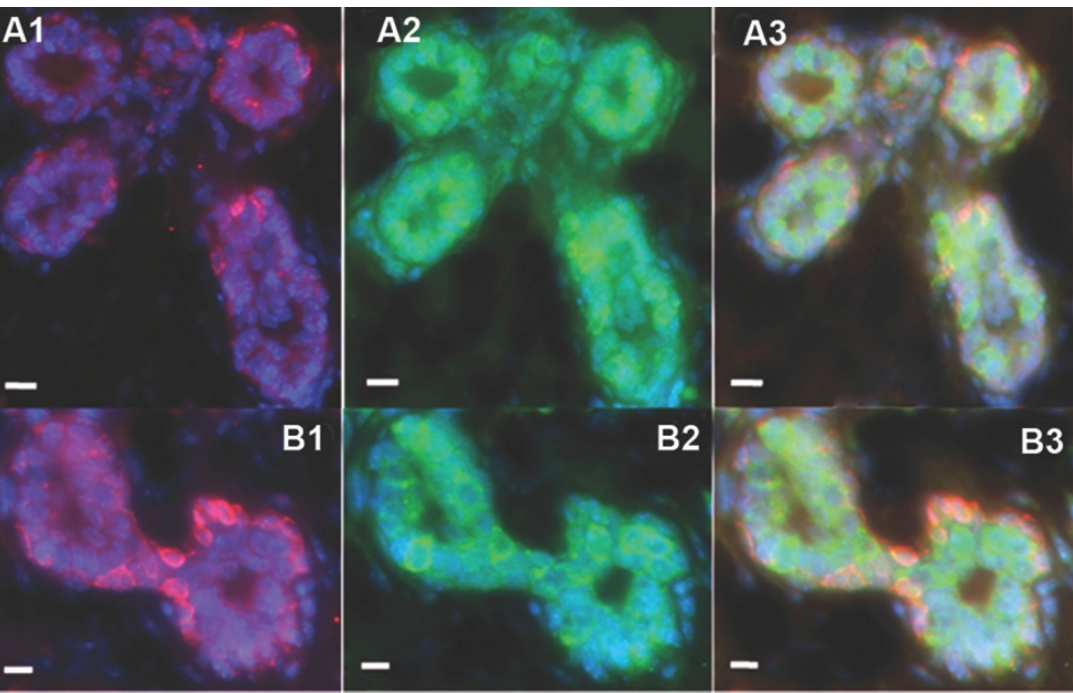
Figure 2. Human cancer cells are able to self-renew and contribute to both luminal (hK8-positive) and basal (hK5-positive) epithelial cell progeny in the chimeric mammary gland outgrowths. Immunofluorescence staining of primary (A1-A3) and secondary (B1-B3) mouse mammary outgrowths. Primary outgrowths were obtained by inoculating both human embryonal carcinoma (NT2) and normal mammary epithelial cells. Secondary outgrowths were generated by transplanting NT2/MEC primary mammary outgrowths fragments into epithelium-deprived fat pad of Nu/Nu mice. A1, B1) Human-specific myoepithelial markers keratin 5 (red). A2, B2) Human-specific luminal marker keratin 8 (green). A3, B3) Merge. All sections are counterstained with DAPI (blue). Scale bars = 10 